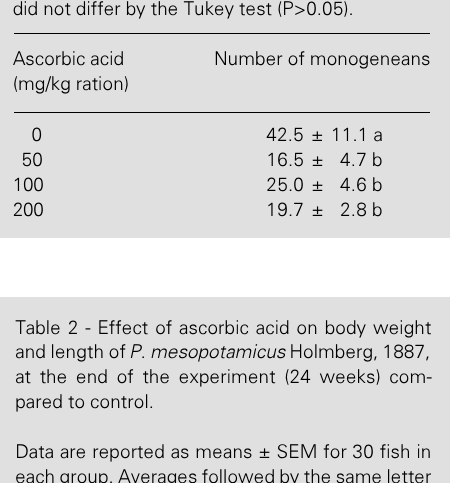
Table 1 - Number of monogeneans in the gills of P. mesopotamicus Holmberg, 1887 fed different lev- els of vitamin C for 24 weeks. Data are reported as means – SEM for 10 fish in each group. Averages followed by the same letter did not differ by the Tukey test (P>0.05).